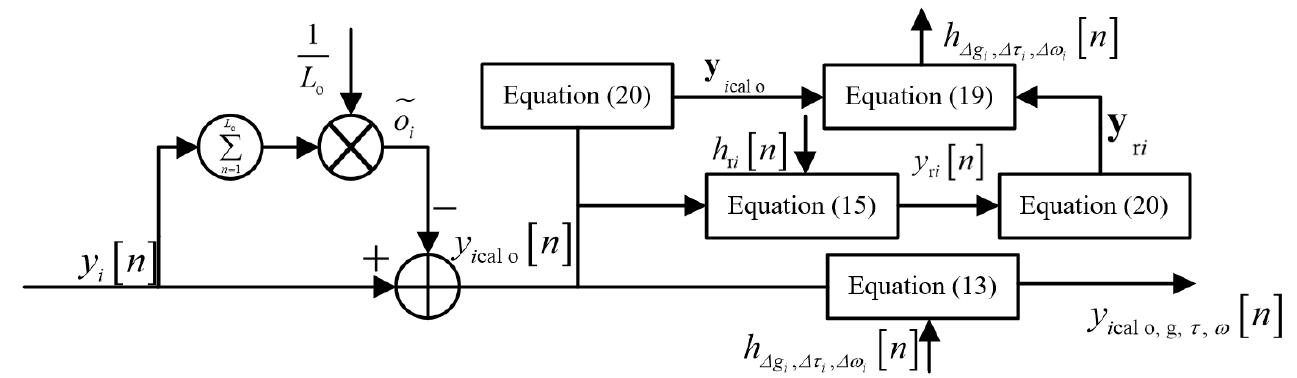
Figure 4. Proposed structure of correction of the offset, gain, time skew, and bandwidth mismatch.